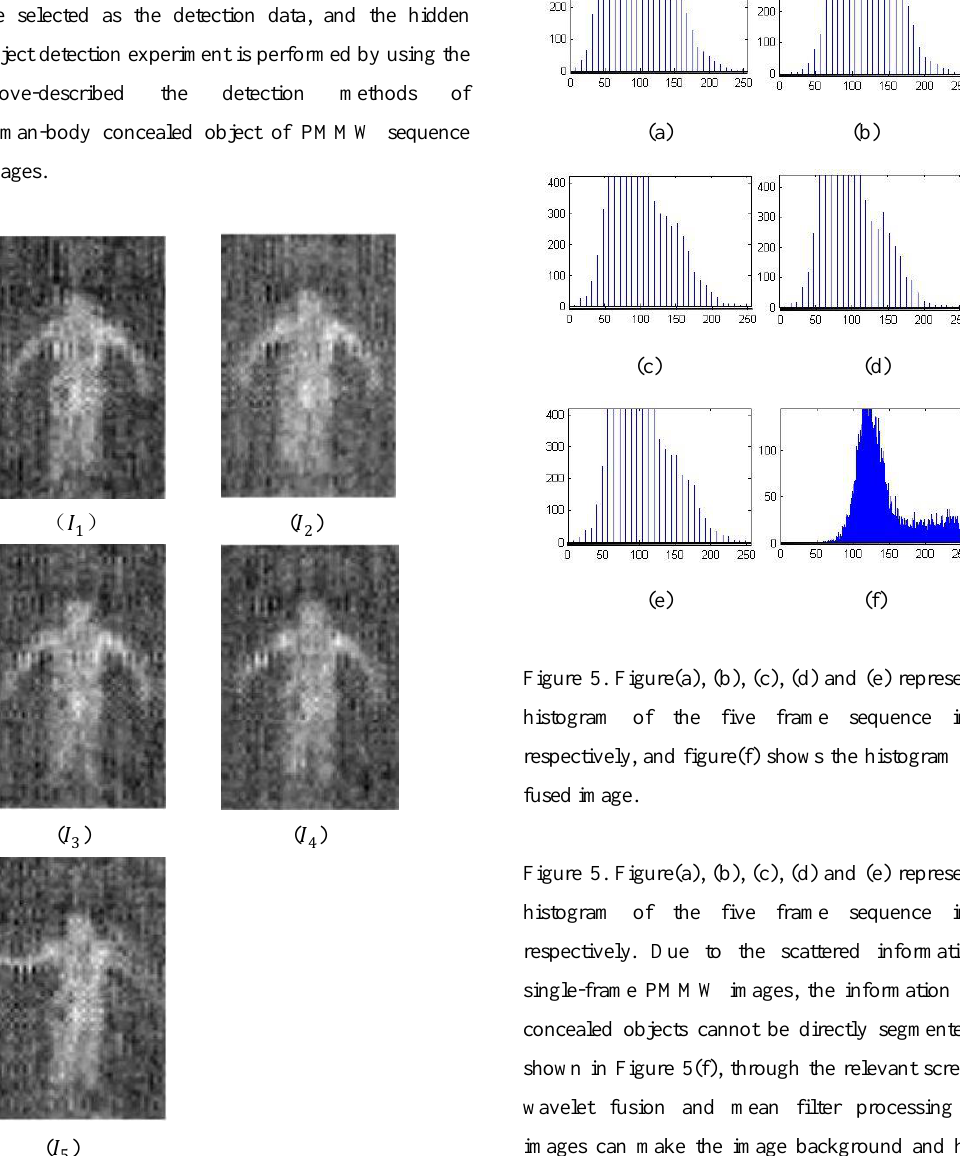
Figure 4. Five frame sequence images of PMMW